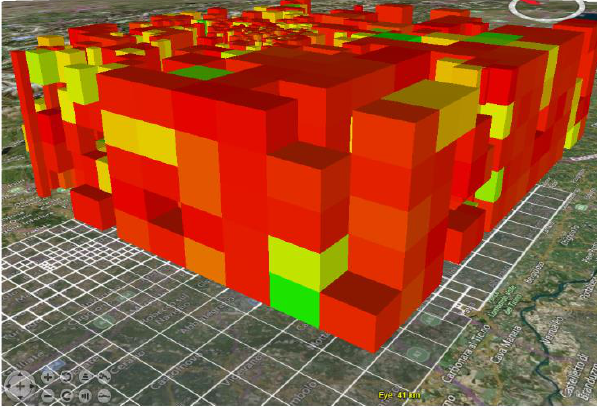
Figure 6. Voxels representing outgoing calls over Milano